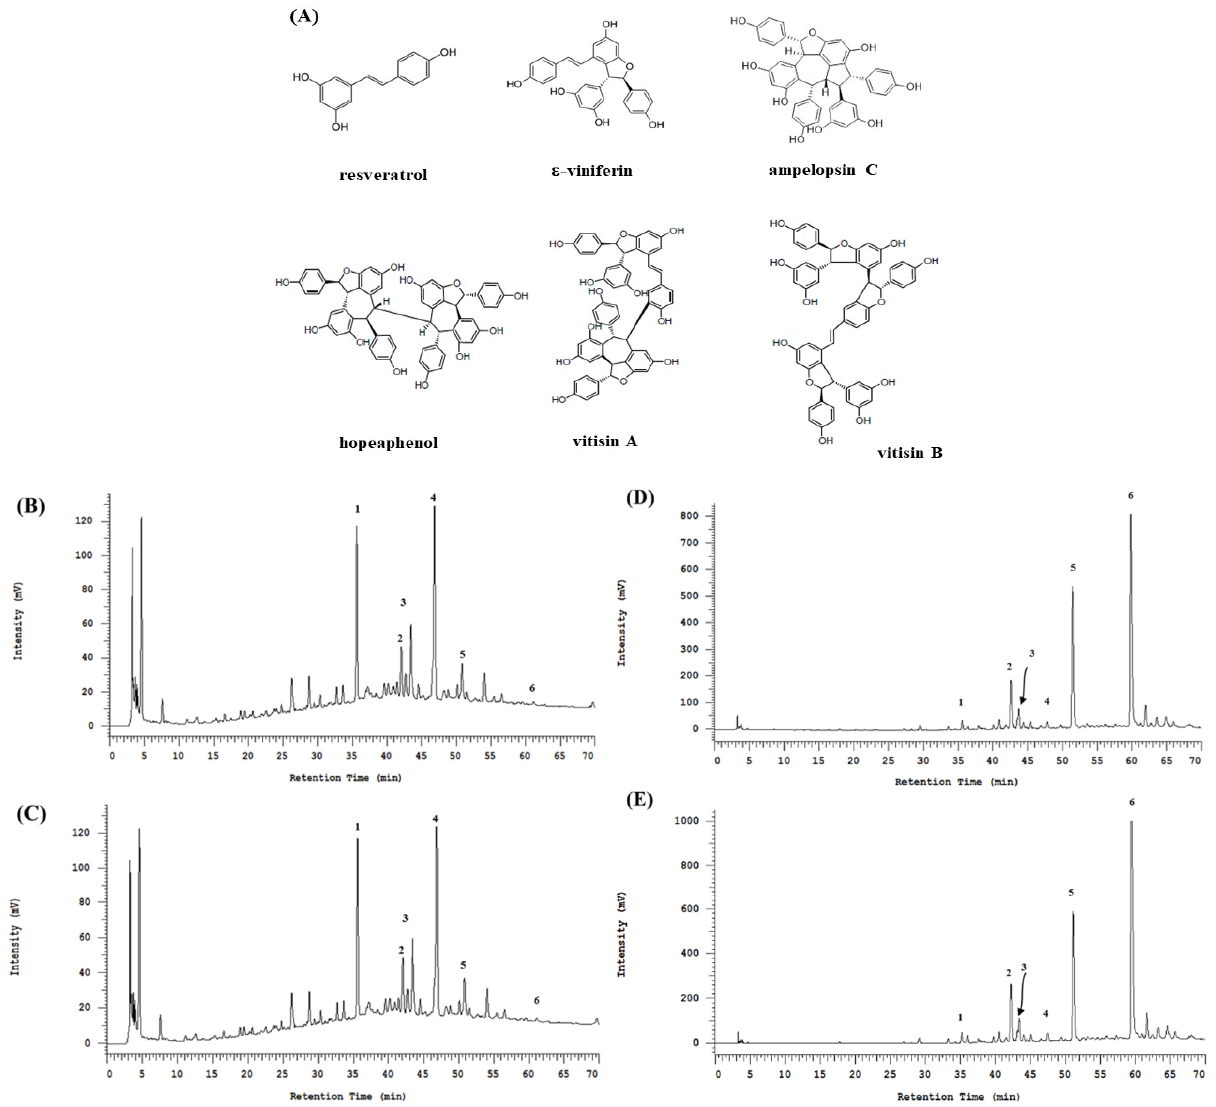
Figure 2. ( A ) The structures of the resveratrol and resveratrol oligomers, including resveratrol dimer of (+)- ε -viniferin, resveratrol trimer of ampelopsin C, and resveratrol tetramers of (+)-vitisin A, (+)-hopeaphenol, and ( − )-vitisin B. The HPLC chromatograms of ( B ) VT-95EE; ( C ) VT-95EE-EA; ( D ) VTT-R-95EE; and ( E ) VTT-R-95EE-EA. The identified compounds included resveratrol (peak 1), (+)-hopeaphenol (resveratrol tetramer, peak 2), (+)-ampelopsin C (resveratrol trimer, peak 3), (+)- ε -viniferin (resveratrol dimer, peak 4), (+)-vitisin A (resveratrol tetramer, peak 5), and ( − )-vitisin B (resveratrol tetramer, peak 6) based on the elution sequence. Table 1. The composition profiles of identified resveratrol and its oligomers in HPLC chromato- grams of extracts and partitioned fractions # .